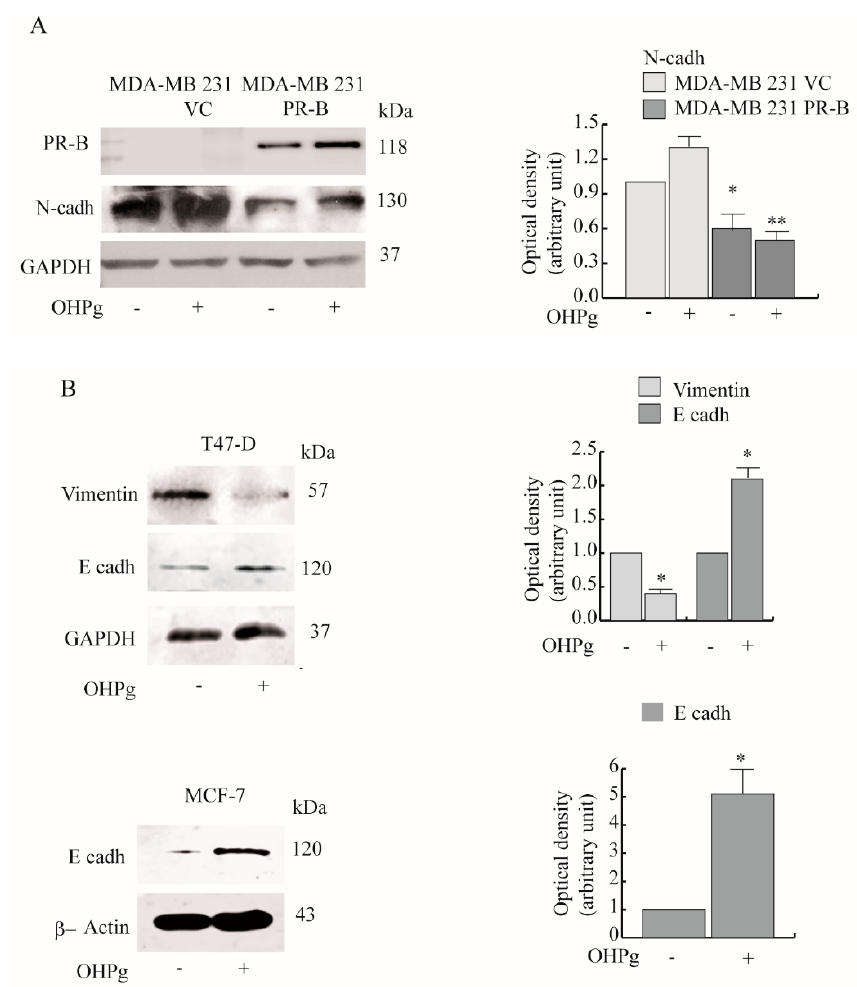
Figure 2. OHPg effects on N-cadherin (N-cadh), E-cadherin (E-cadh) and Vimentin expression in breast cancer cells . ( A ) Immunoblot analyses for PR-B and N-cadh expression. MDA-MB-231 cells transfected with vector control or PR-B expression vector were treated for 24 hours, as indicated. Glyceraldehyde 3-phosphate dehydrogenase (GAPDH), control for loading. Columns refer to three independent experiments, as the mean of the band optical density expressed as fold over vehicle, which was assumed to be 1; bars, SD. * p ≤ 0.05 vs. vehicle-treated cells. ** p ≤ 0.05 vs. OHPg-treated cells. ( B ) Immunoblot analyses for Vimentin and E-cadh expression in T47-D and MCF-7 cells, as indicated. GAPDH and β -Actin, control for loading * p ≤ 0.05 vs. vehicle-treated cells.